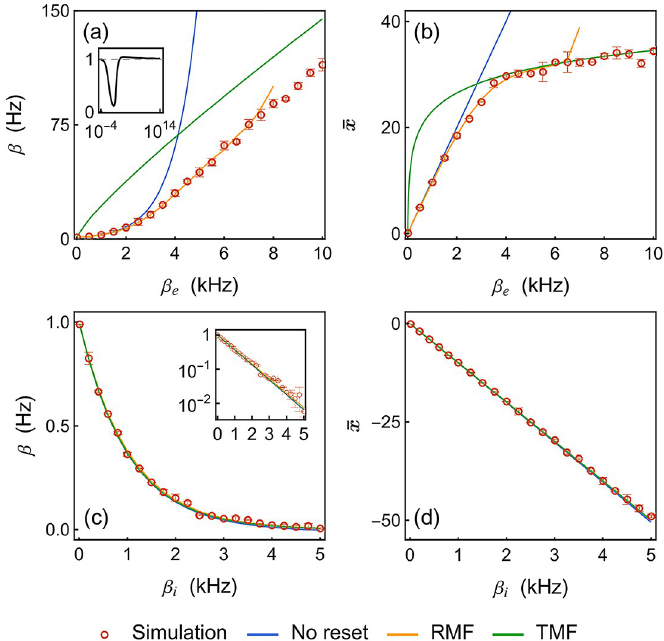
Fig 6. Rate-transfer functions: Mean firing rates β and mean internal variables � x . For panel (a) and (b), the neuron is subjected to an excitatory input with varying rates β from 0 to 10 kHz and fixed strength μ = 1.0. In panel (a), the e e top-left inset shows the ratio β / β TMF in a wider range of input rates. For panel (c) and (d), the neuron is subjected to an inhibitory input with varying rates β i from 0 to 5 kHz and fixed strength μ i = − 1.0. The inset in panel (c) is in logarithmic scale to show its exponential dependence. For the simulated data, we run the event-driven simulation until 400 spiking events for the single neuron are accumulated. This process is repeated 32 times. During each repetition, we record the total time T ( k = 1, ��� , 32). The mean firing rates of the neuron are then computed by k � b ¼ ð P 32 400 = T Þ = 32 . The standard deviations of the rates (indicated by error bars) over these 32 repetitions are k P k ¼ 1 32 computed by taking the square root of ð ð S ¼ 400 = T Þ 2 (cid:0) � b 2 Þ = ð 32 (cid:0) 1 Þ . Meanwhile, we record the entire time k k ¼ 1 series of the internal variable x , with which we compute the mean of x . The standard deviations of the internal variable x (indicated by error bars) are computed over these 32 repetitions. Parameters: h = 1 Hz, a = 0.1, τ = 10 ms.